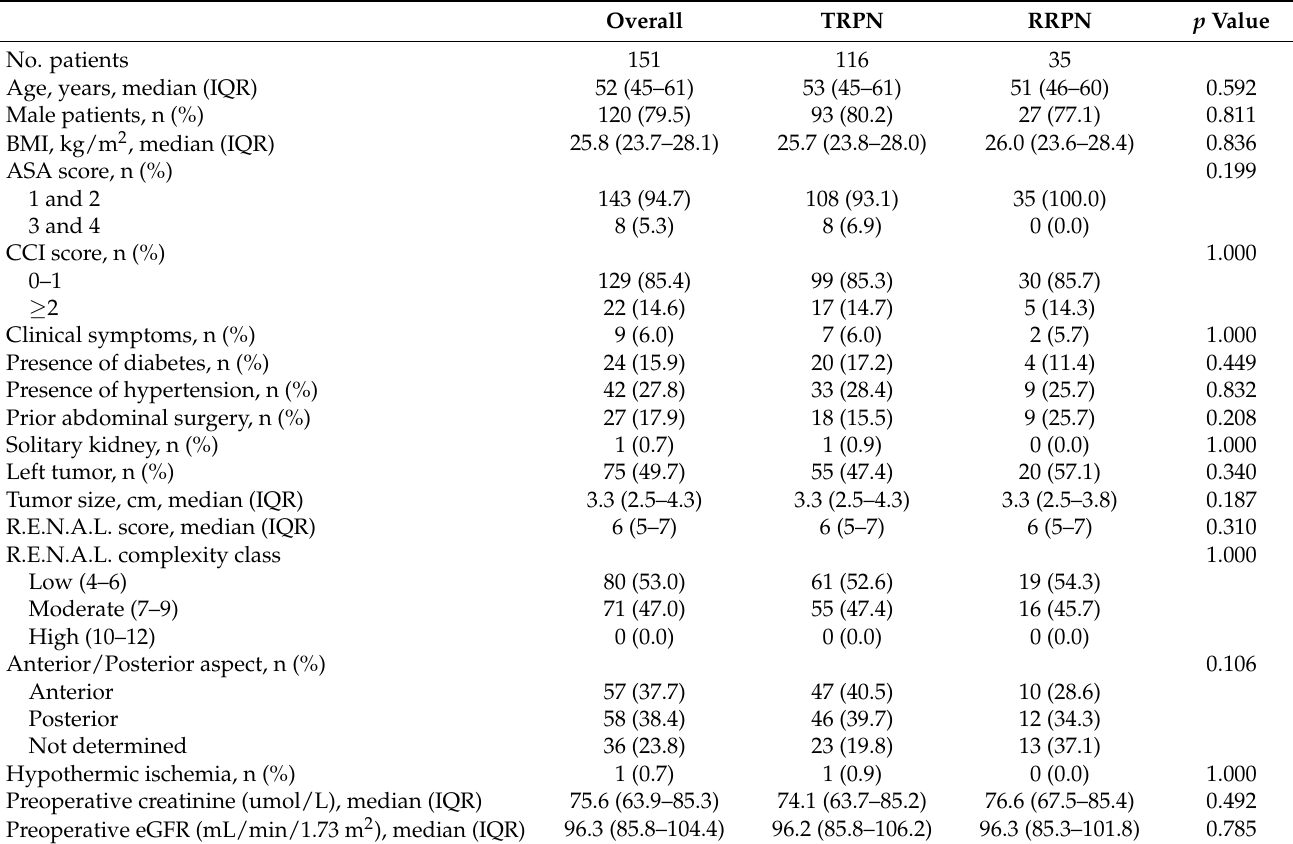
Table 1. Patients’ demographics and tumor characteristics.